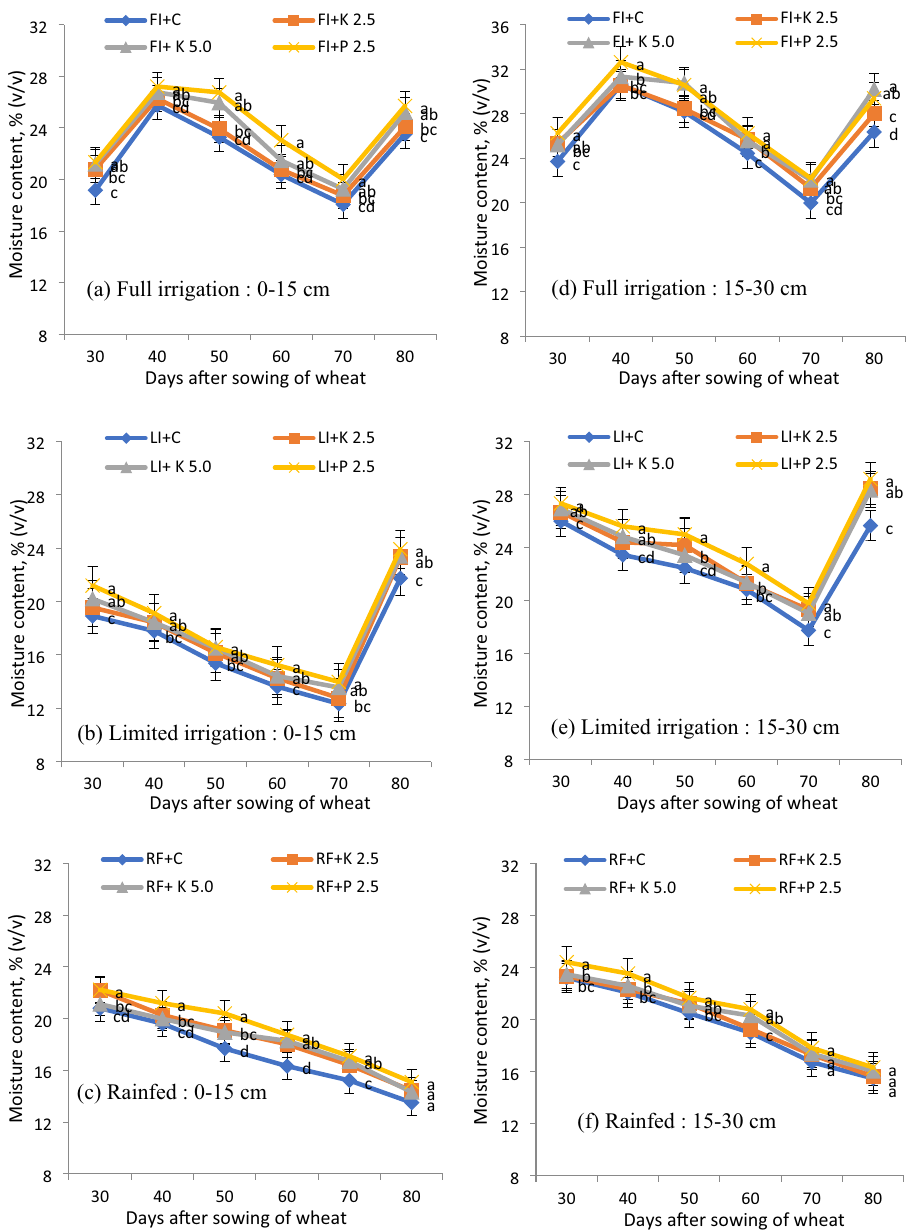
Figure 4. Volumetric water content (v/v) in wheat under different hydrogels and irrigation regimes at 0–15 ( a–c ) and 15–30 ( d–f ) cm soil depths during 2017–2018. Bars indicate standard error of mean. FI full irrigation, LI limited irrigation, RF rainfed; gel, hydrogel. Means followed by a similar superscript letter within a column are not significantly different (at P ≤ 0.05) between treatments allowing to least significant difference